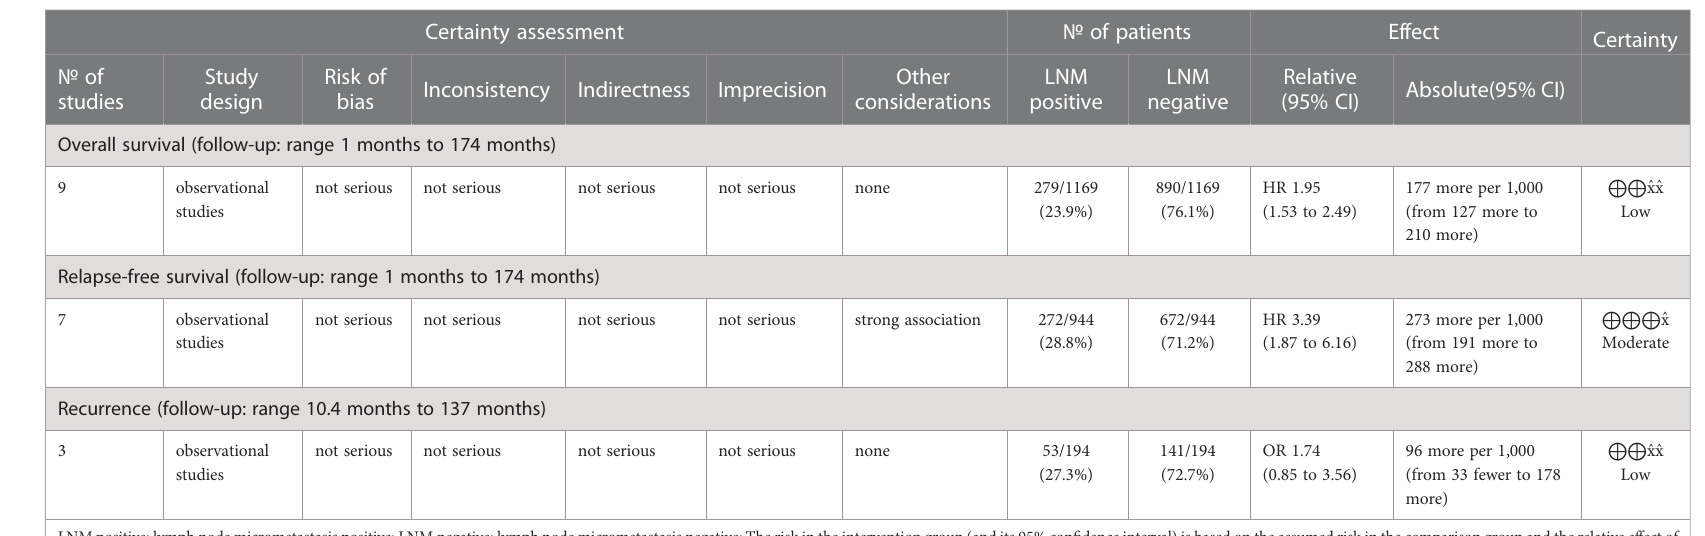
TABLE 3 Summary of the results of